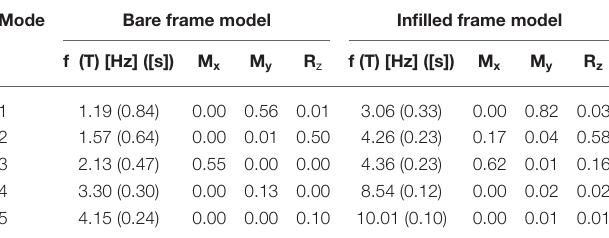
TABLE 2 | Frequencies and percentage of participation masses for bare and infilled